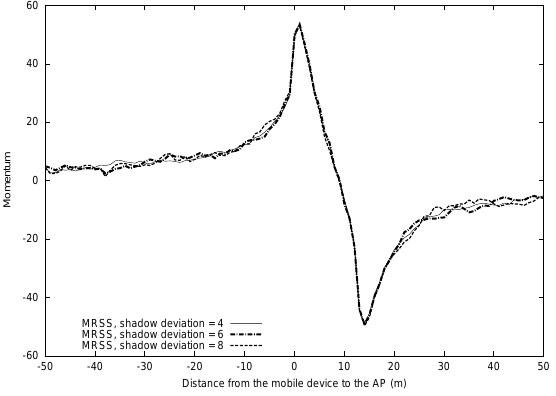
Figure 6. The effect of shadow deviation when α = 0.16, k = 32 in the WLAN environment.